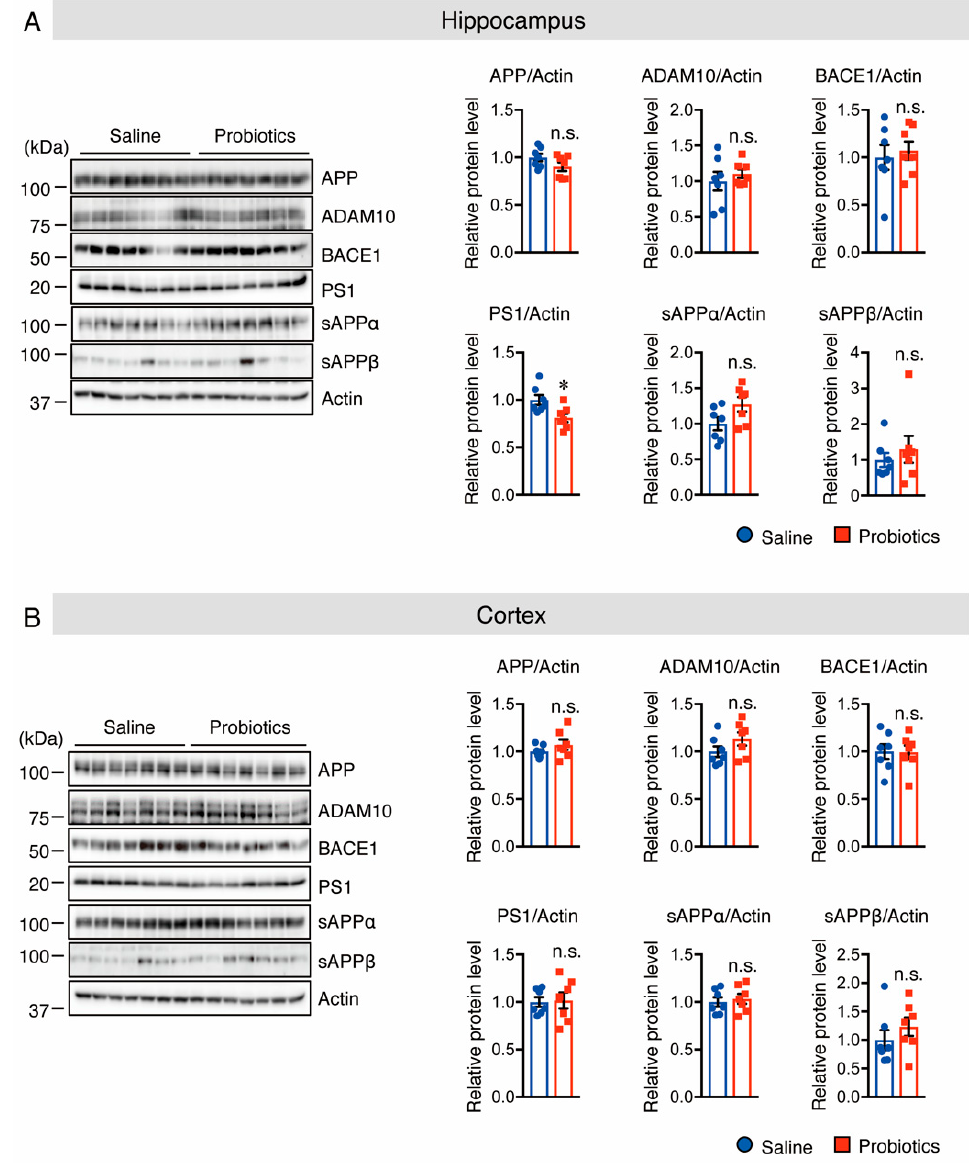
Figure 3. Oral supplementation of B. breve MCC1274 decreases PS1 protein level in the hippocampus of WT mice. Western blot analysis of APP, ADAM10, BACE1, PS1, sAPP α , sAPP β , and actin in the hippocampus ( A ) and cortex ( B ). The protein levels were quantified by densitometry, normalized to the actin level, and expressed as a relative protein level. Data are represented as mean ± SD; n = 7 per group; n.s. no significant difference; * p < 0.05 compared with the saline group, as determined by Student’s t -test.